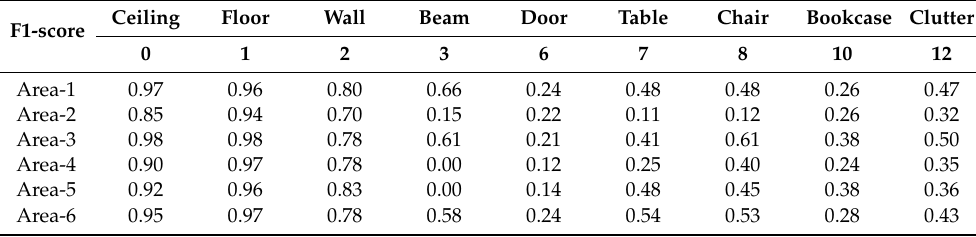
Table A2. Summary of the 6 areas using our semantic segmentation